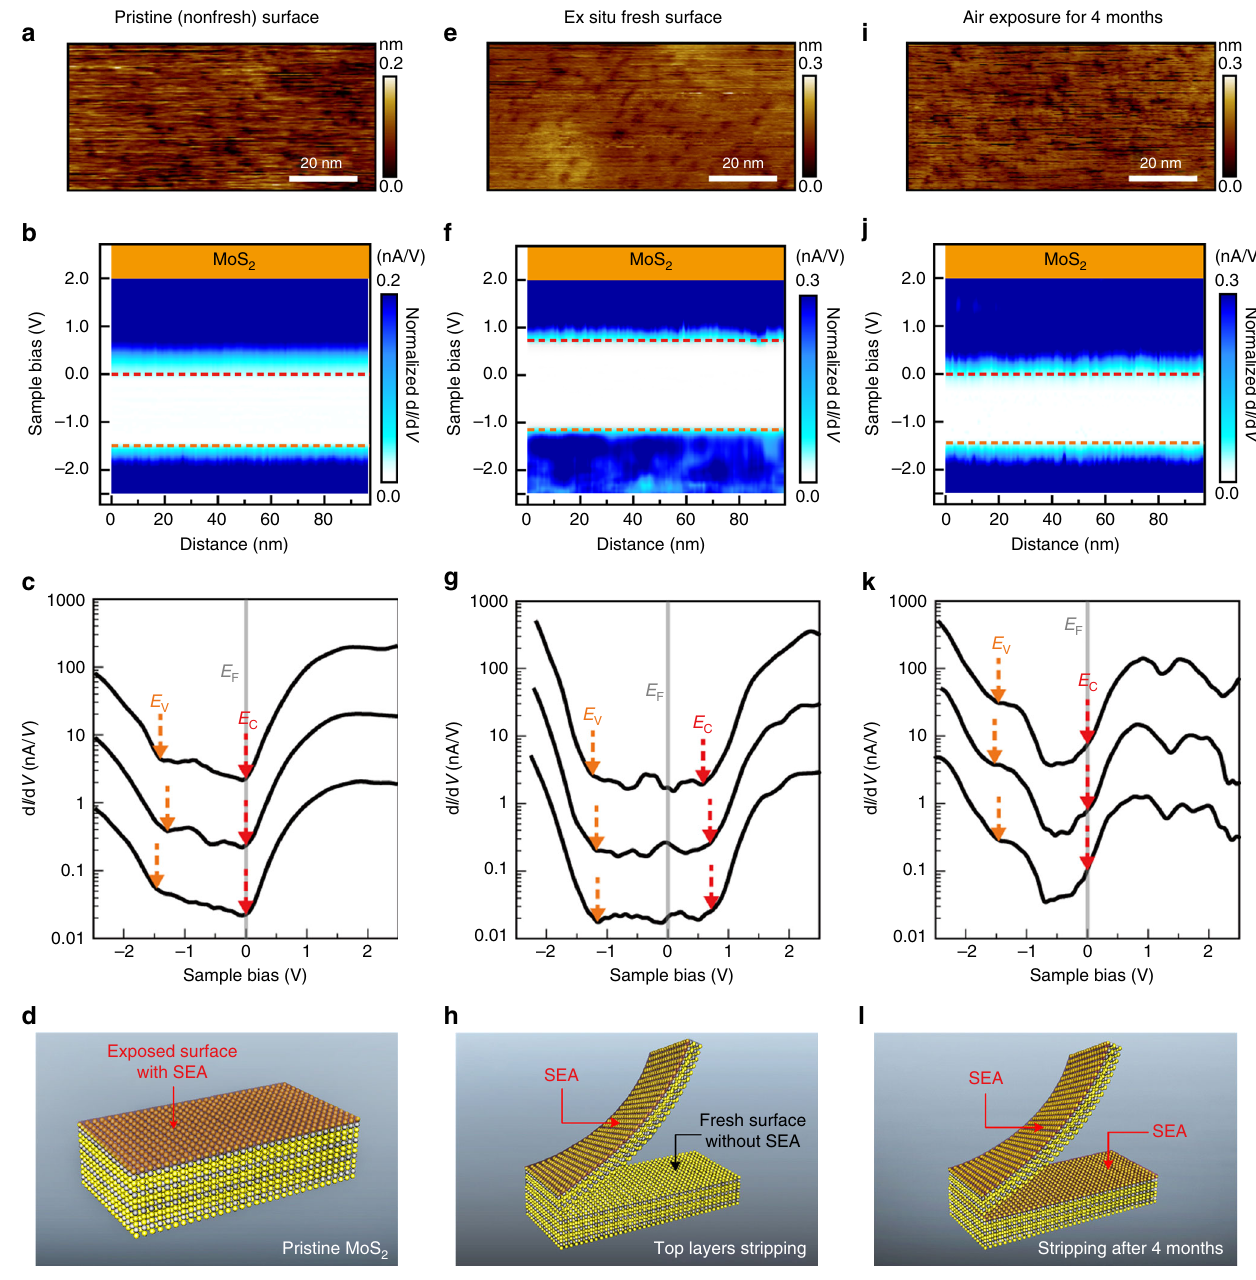
Fig. 6 STM/STS characterization and surface electron accumulation (SEA) of a MoS 2 single crystal. a STM image, b band alignment, and c d I /d V curve measurements for the non-fresh surface of a pristine MoS 2 crystal. d Schematic SEA of pristine MoS 2 . e STM image, f band alignment, and g d I /d V curve measurements for the fresh surface of an MoS 2 crystal. h Schematic shows the fresh surface of MoS 2 without SEA and the original non-fresh surface with SEA. i STM image, j band alignment, and k d I /d V curve measurements for the fresh surface of an MoS 2 crystal exposed to air for four months. l Schematic showing the SEA formation at the fresh surface of MoS 2 after four months exposure to